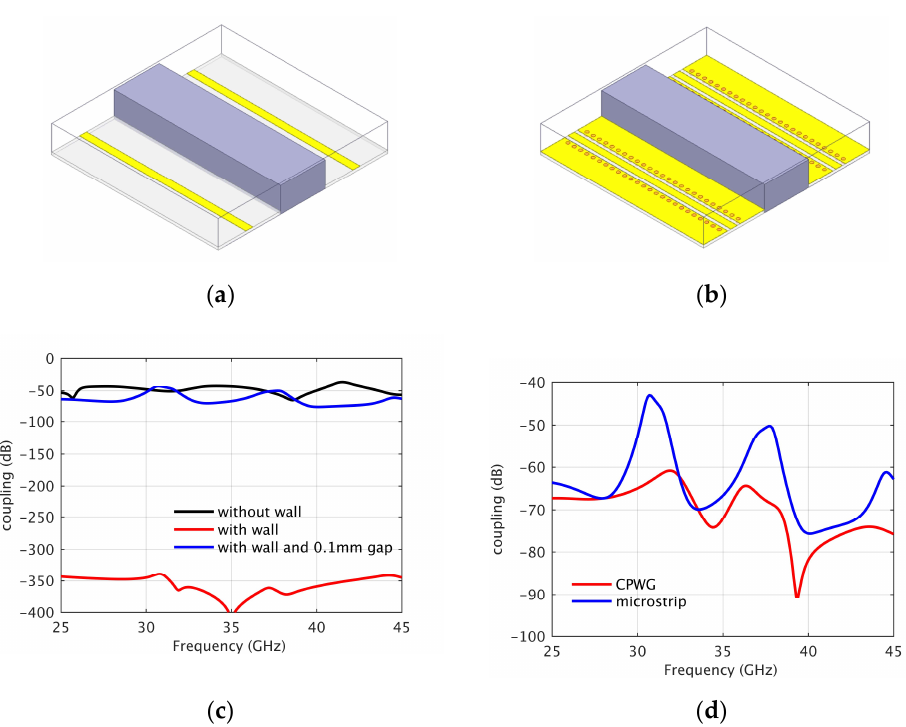
Figure 13. ( a ) Two channels microstrip line model. ( b ) Two-channel CPWG line model. ( c ) Simulation results of microstrip line model in different states. ( d ) Comparison of simulation results between CPWG and microstrip line model.